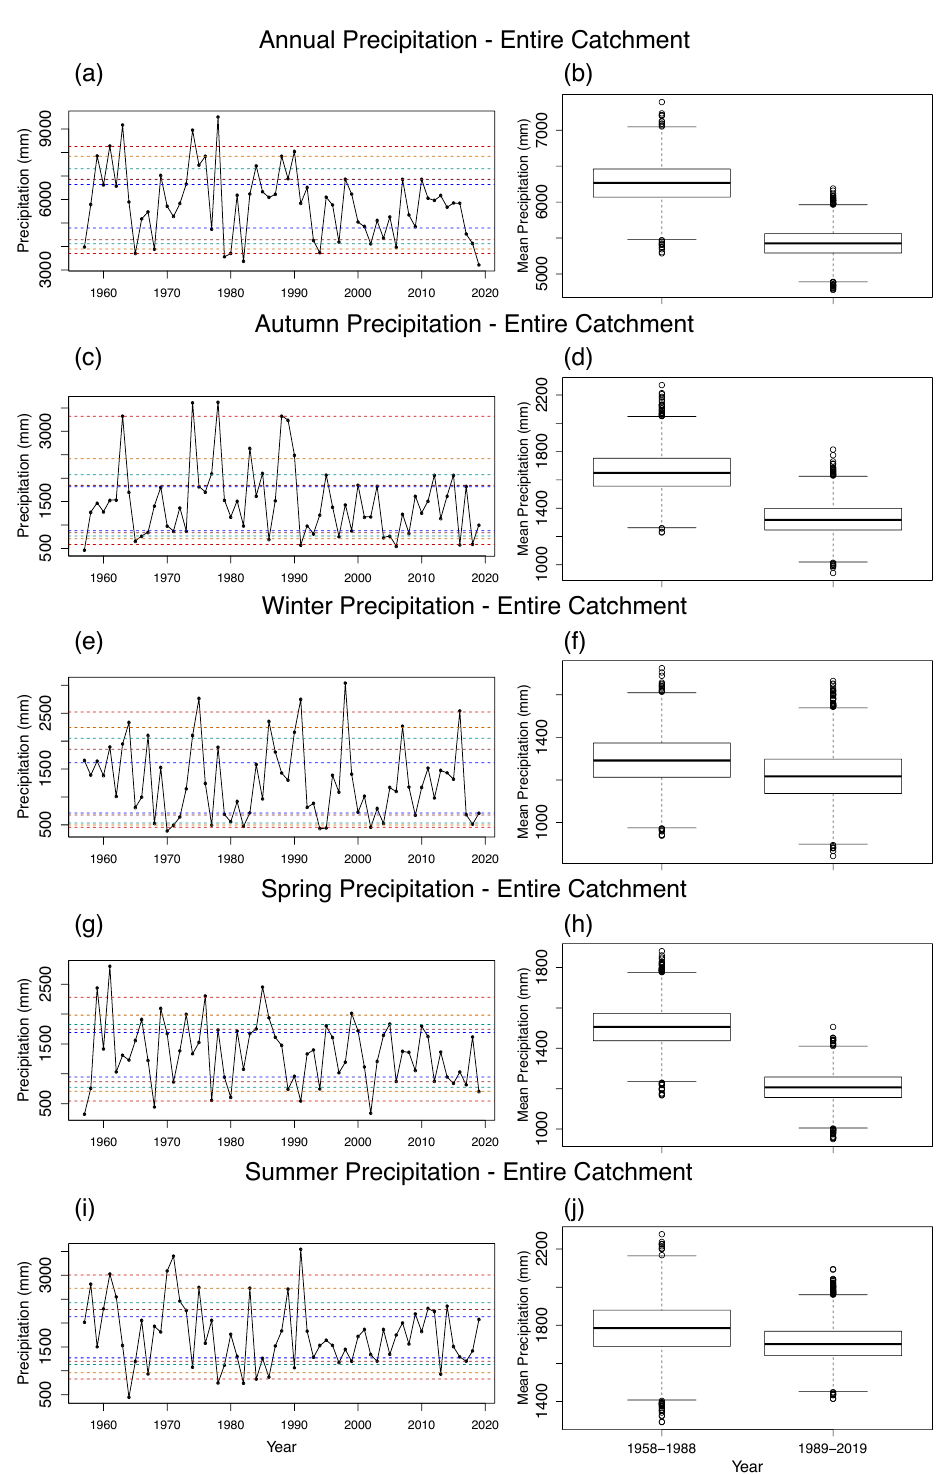
Figure 3. (left panels, ( a , c , e , g , i )) Annual precipitation time series summed across all six sites. Dashed lines indicate the 5th and 95th (bottom and top red), 10th and 90th (bottom and top orange), 15th and 85th (bottom and top green), 20th and 80th (bottom and top brown) and 25th and 75th percentiles (bottom and top dark blue); and (right panels, ( b , d , f , h , j )) box plots of the bootstrapped mean annual precipitation over 31-year periods for the